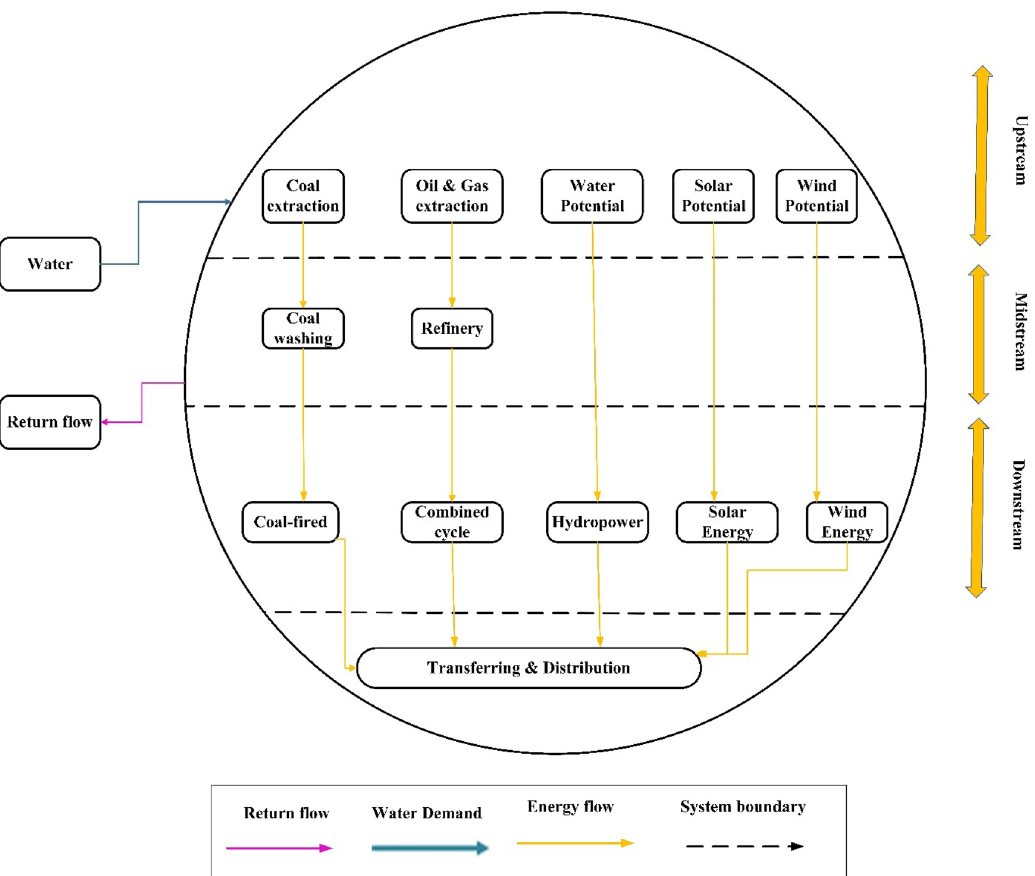
Figure 8. Supply-side of energy subsystem’s